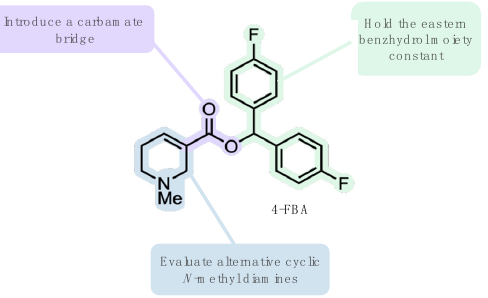
Figure 2. General structural modification strategy of parent compound 4-FBA [16].